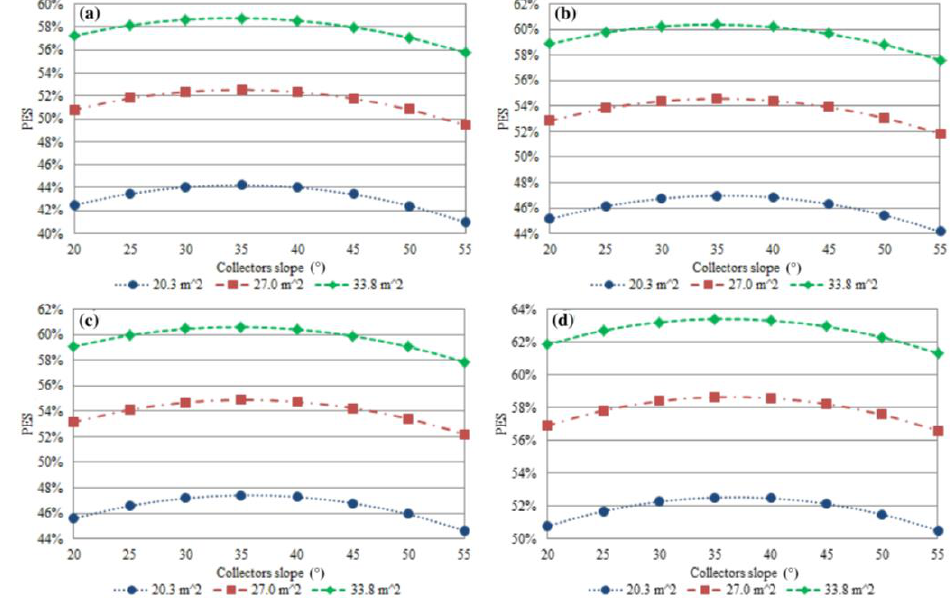
Figure 11. Primary energy saving of the ASs with 100% of solar thermal energy surplus used and flat-plate collectors in the four alternative configurations: ( a ) Scenario A; ( b ) Scenario B; ( c ) Scenario C; and ( d ) Scenario D.